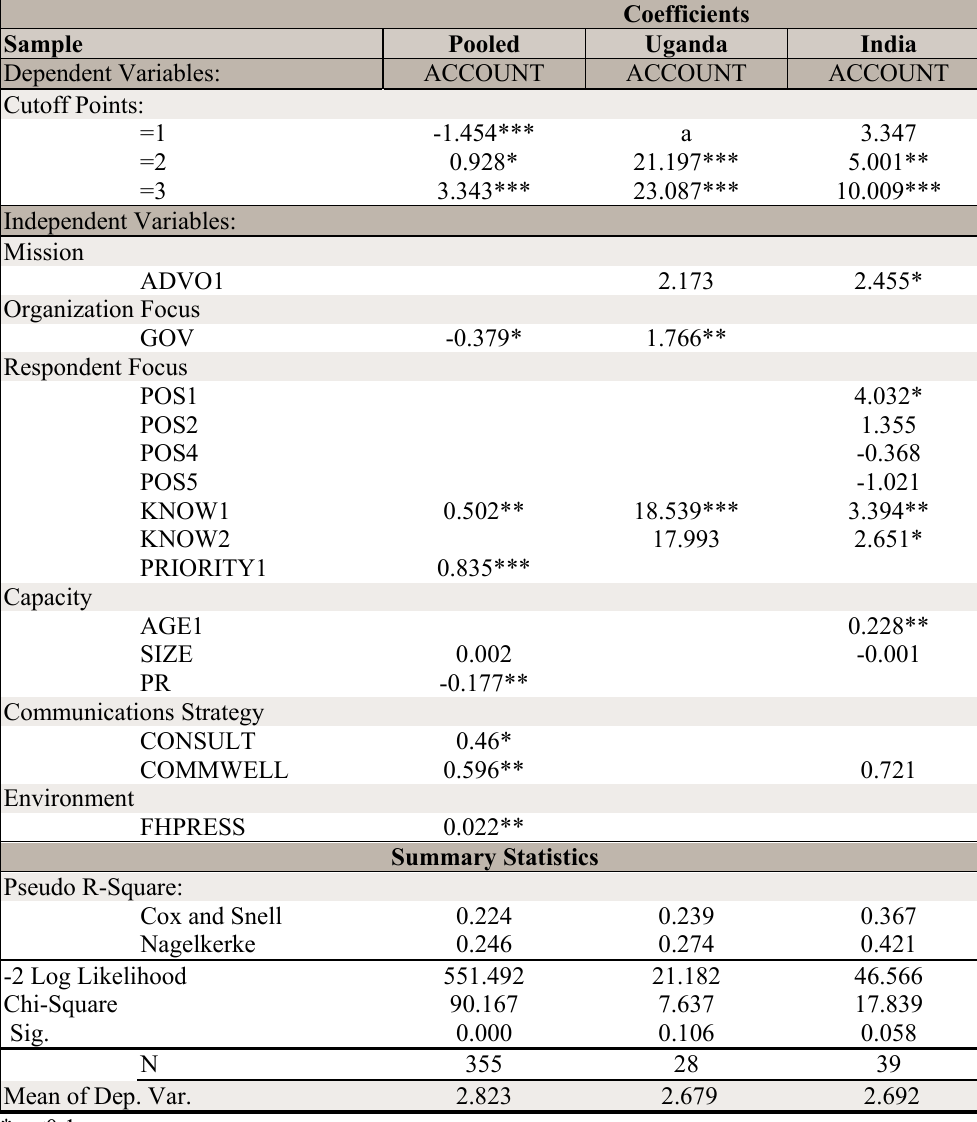
Table 5. Estimated Models for ACCOUNT Using Pooled, India, and Uganda